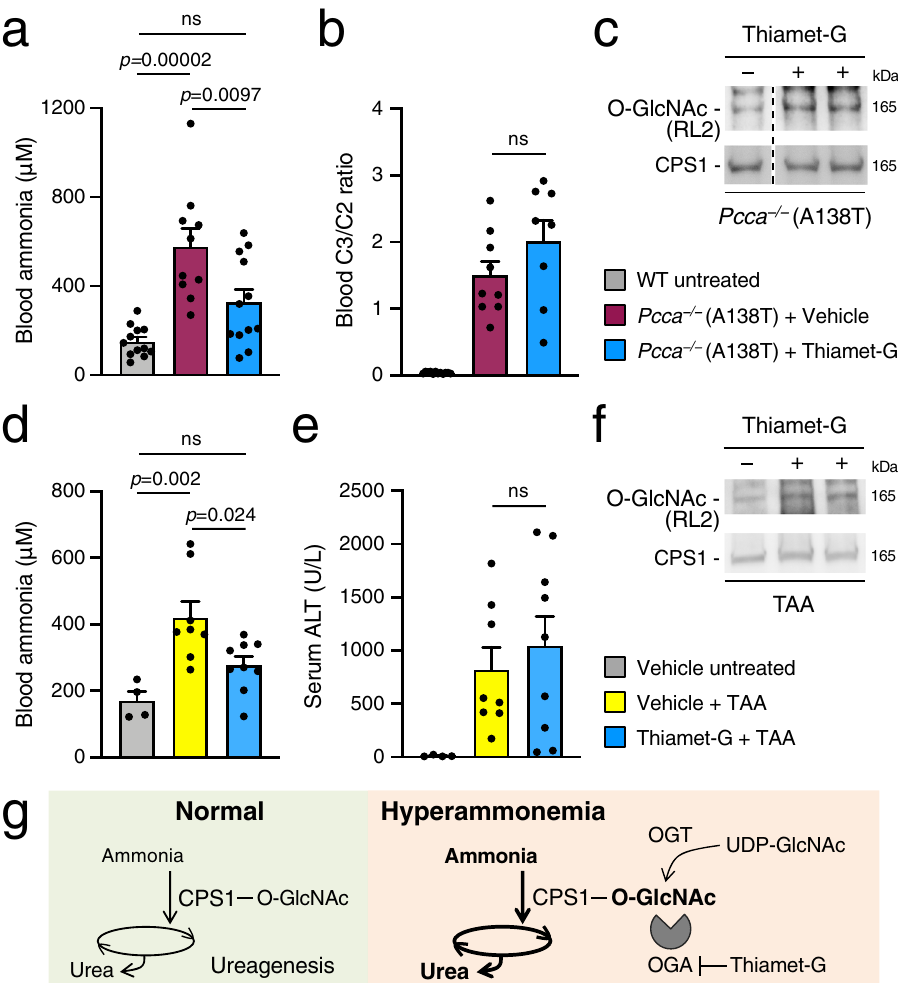
Fig. 5 | OGA inhibition reduced hyperammonemia in mouse models of both inherited and acquired liver diseases. a Blood ammonia in Pcca − / − (A138T) mice injected with Thiamet-G (40mg/kg for 5 days) ( n =12) or vehicle ( n =10). Age- matched C57BL/6 wild-type (WT) untreated mice were used as controls ( n =12). p =0.00002, p =0.0097 (one-way ANOVA). b Ratio of propionylcarnitine (C3) to acetylcarnitine(C2)inseraof Pcca − / − (A138T)micetreatedwithThiamet-G( n =8)or vehicle ( n =9). Age-matched WT untreated mice were used as controls ( n =12) (One-wayANOVA). c Increased O-GlcNAcylation of CPS1 in livers of Pcca − / − (A138T) micei.p. injected with Thiamet-G.Sampleswererun onthe same gelbutwerenon- contiguous. d Blood ammonia in WT mice treated with Thiamet-G (40mg/kg, i.p. for5days)and/orthioacetamide(TAA;250mg/kg,i.p.24hbeforesacri fi